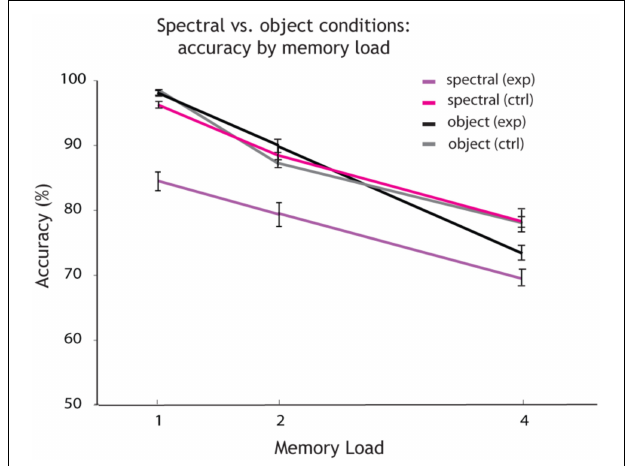
FIGURE 4 | Accuracy by memory load for single feature spectral vs. object conditions. Overall accuracy (percentage correct) for every memory load (1, 2, and 4 auditory objects presented within a sequence). The plot shows how accuracy decreases with an increase in memory load for each condition. Shown in purple are the results for the single feature spectral condition. Spectral is the relevant and temporal the irrelevant feature varied at random. In pink: again spectral is the relevant feature, but the irrelevant temporal feature is held constant (spectral control condition). The results for the object condition are shown in black (the probe changes on both features on change trials). The results for the object control condition (the probe changes by a single feature on change trials) are shown in gray.